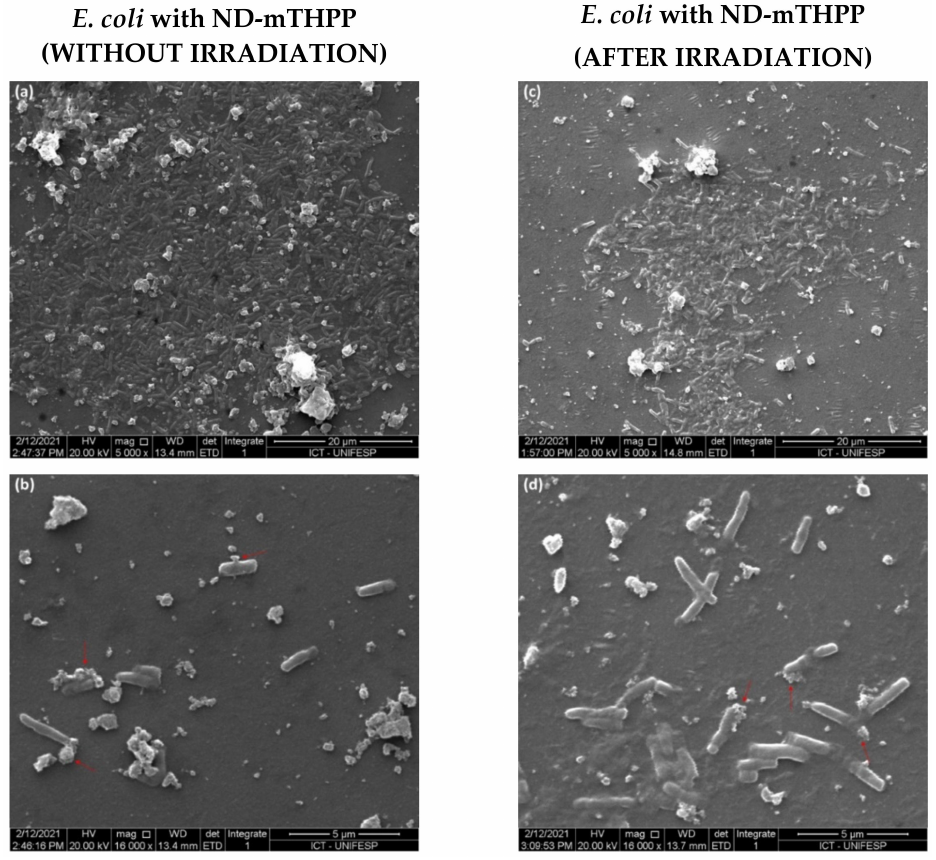
Figure 6. Images of SEM of Escherichia coli grown in the presence of ND-mTHPP in the absence of irradiation ( a , b ) and after irradiation (660 nm; 51 J/cm 2 ) ( c , d